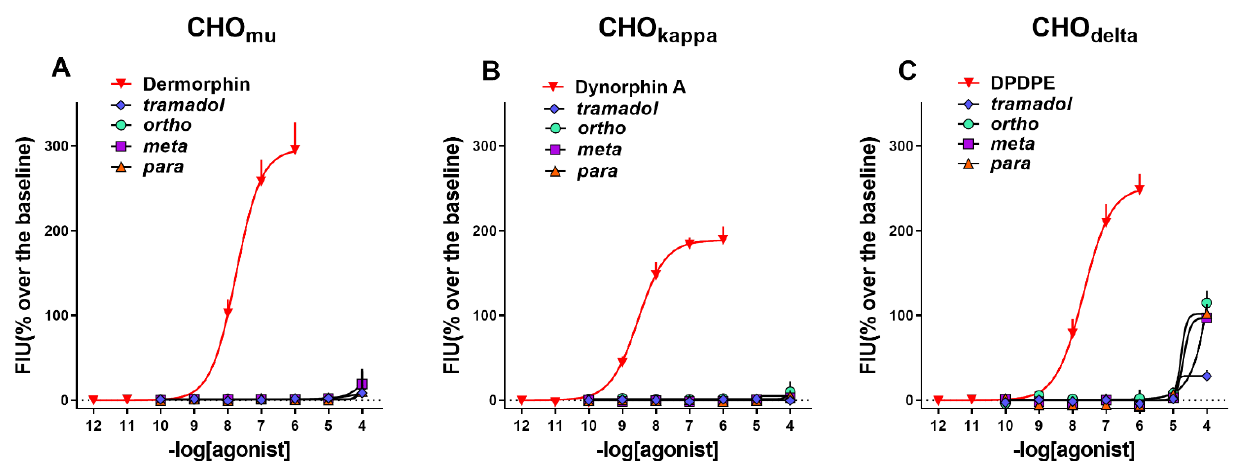
Figure 2. Calcium mobilization assay. Concentration response curves of standard opioid agonists, tramadol, and ortho-, meta- and para-1-cyclohexyl-X-methoxybenzene tested in CHOmu ( A ), CHOkappa ( B ), and CHOdelta cells ( C ). Data are the mean ± sem of 4 separate experiments performed in duplicate.